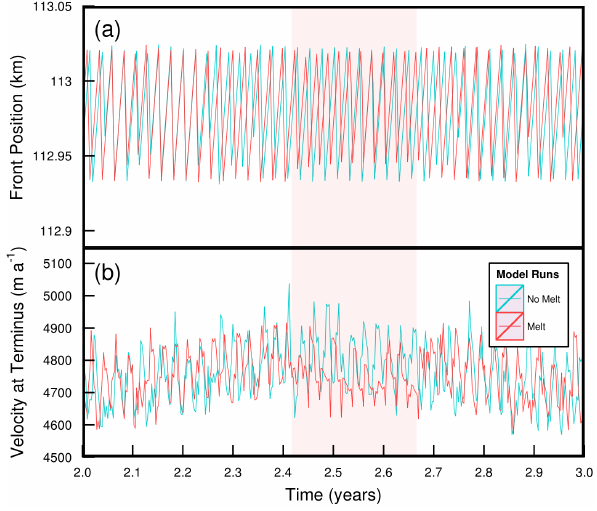
Figure 5. Plots showing variations in terminus position (a) and ve- Figure 6. Plots showing changes in calving terminus position (a) locity (b) over the course of a year for the baseline model run (blue Fig. 6. Plots showing changes in calving terminus position (a) and velocity (b) during a three year period and velocity (b) during a 3-year period within a 40-year-long sta- Fig. 5. Plots showing variations in terminus position (a) and velocity (b) , over the course of a year for line) and a run with submarine melting applied (red line). Red shad- ble simulation, with coloured solid lines illustrating the effect of within a 40 year long stable simulation, with coloured solid lines illustrating the effect of four different ing indicates melt season. The saw-toothed pattern in both panels is baseline model run (blue line) and run with submarine melting applied (red line). Red shading indicates four different combinations of melting and ice mélange perturba- combinations of melting and ice m´elange perturbation. Blue and red shade indicates m´elange and melt a result of calving. tion. Blue and red shading indicates mélange and melt season, re- melt season. The saw-toothed pattern in both panels is a result of calving. season respectively.